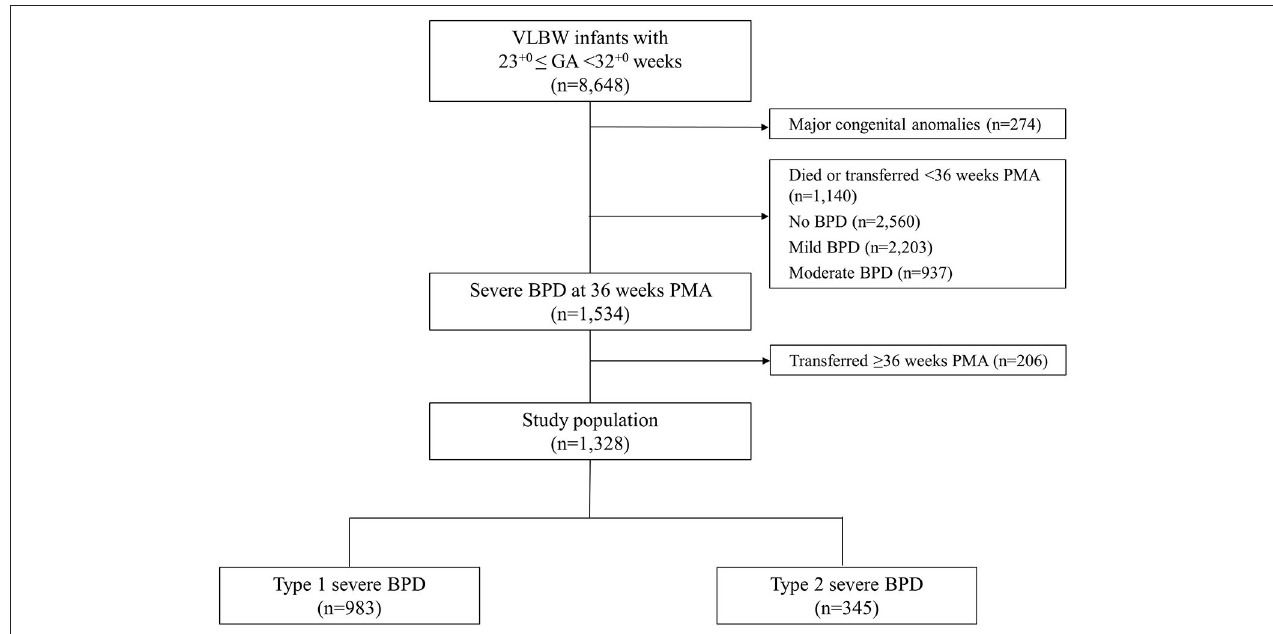
FIGURE 1 | Study population. VLBW, very low birth weight; GA, gestational age; BPD, bronchopulmonary dysplasia; PMA, post-menstrual